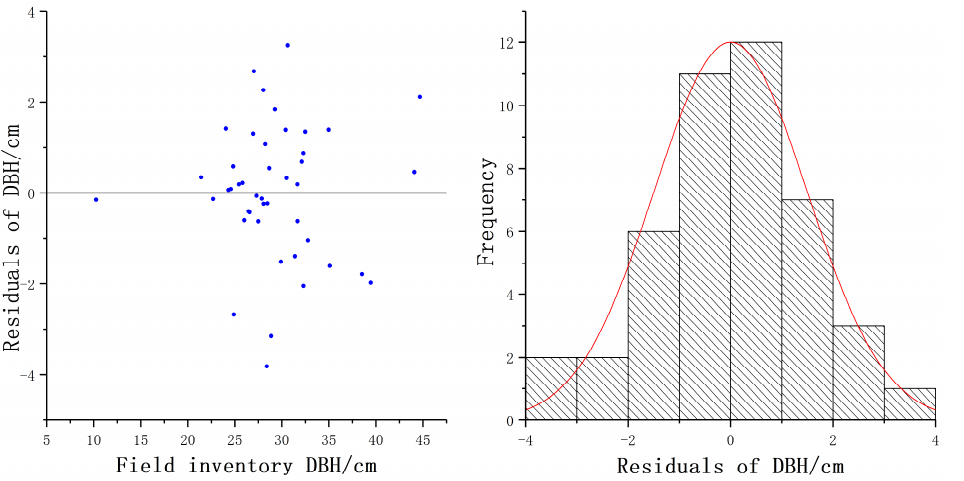
Figure 12. The residuals distribution of DBH.